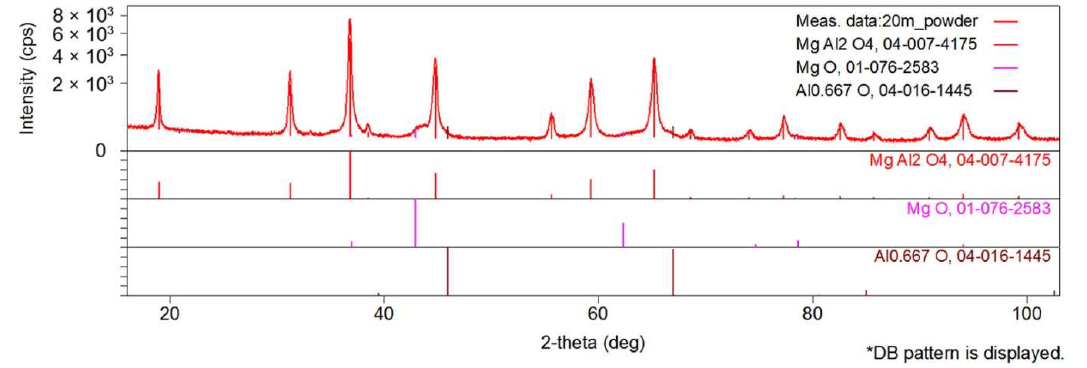
Figure A7. AZ63_20m in powder form sample—XRD qualitative phase analysis with displayed PDF cards peak bars.